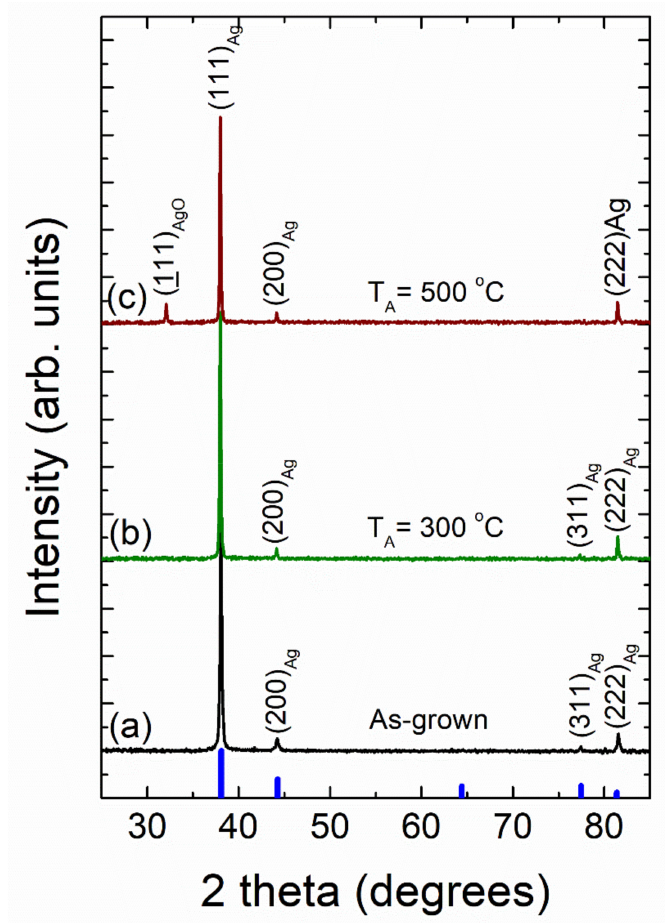
Figure 11. X-ray diffraction patterns of vacuum-thermal-evaporated silver layers with a nominal thickness d Ag = 80 nm at different stages of the annealing step during the SSD process by applying the heat-up region program depicted in Figure 1 and ending at different T A values: ( a ) as-grown silver layer, ( b ) T A = 300 ◦ C, and ( c ) T A = 500 ◦ C. Miller indices (hkl) for cubic silver diffraction planes are indicated. Cubic Ag JCPDS pattern is also shown for comparison (thick blue bars). Temperature ramp rate =10 ◦ C /min. In all of these cases, a soda lime glass substrate has been